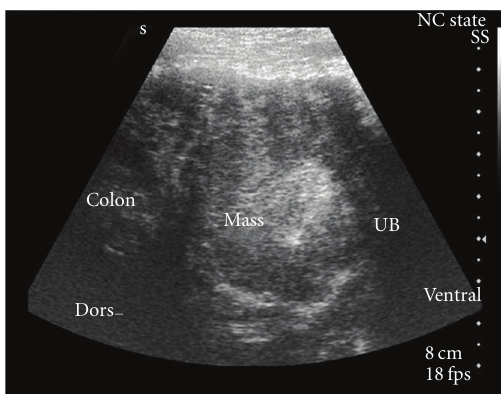
Figure 1: Abdominal ultrasound image from a young dog with a large caudal abdominal mass between the colon and the urinary bladder (UB). Primary di ff erential diagnosis was a granuloma or